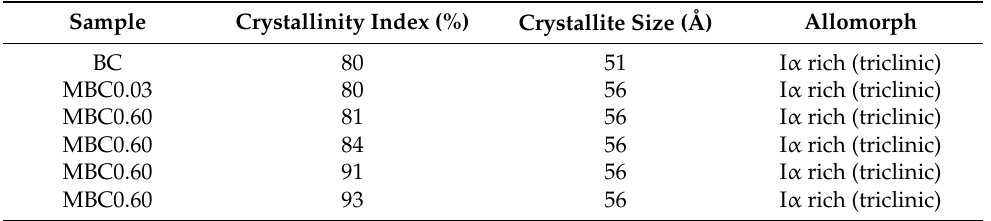
Table 1. Calculated crystallinity indexes and crystallite sizes of the modified and unmodified samples.